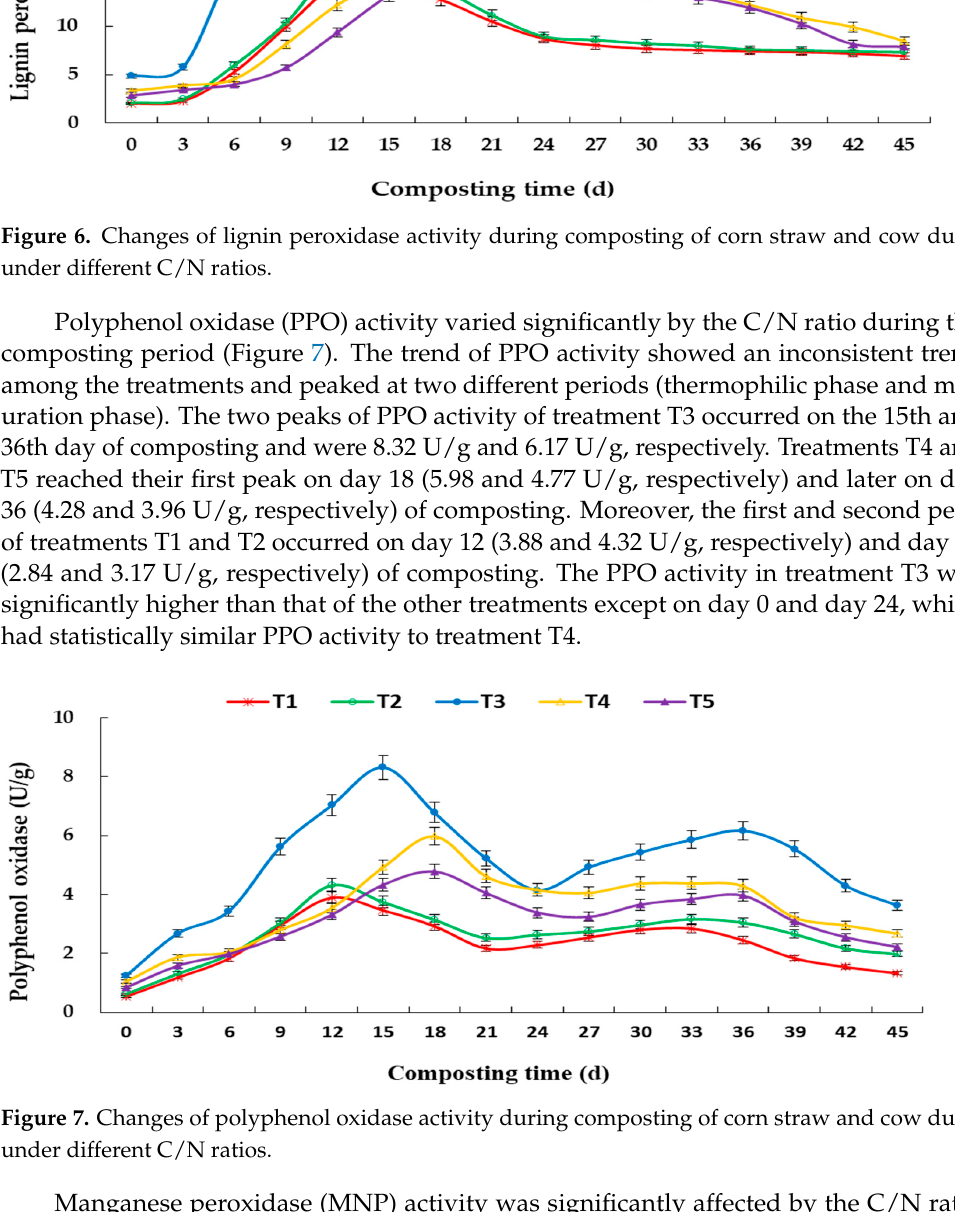
Figure 8. Changes of manganese peroxidase activity during composting of corn straw and cow dung under different C/N ratios. Peroxidase (POD) mainly oxidizes organic matter during composting and it was sig- nificantly varied by the C/N ratio during the composting process (Figure 9). Similar to the MNP activity, POD activity increased with the duration of the composting process up to a certain point and then decreased until the end of the experiment (45 days). Treatments T3, T4, and T5 peaked on day 15 of composting (0.82, 0.53 and 0.46 U/g, respectively), while treatments T1 and T2 peaked on day 12 of composting (0.33 and 0.38 U/g, respec- tively). Treatment T3 had the highest POD activity throughout the composting period, while treatment T1 had the lowest activity throughout the composting period.